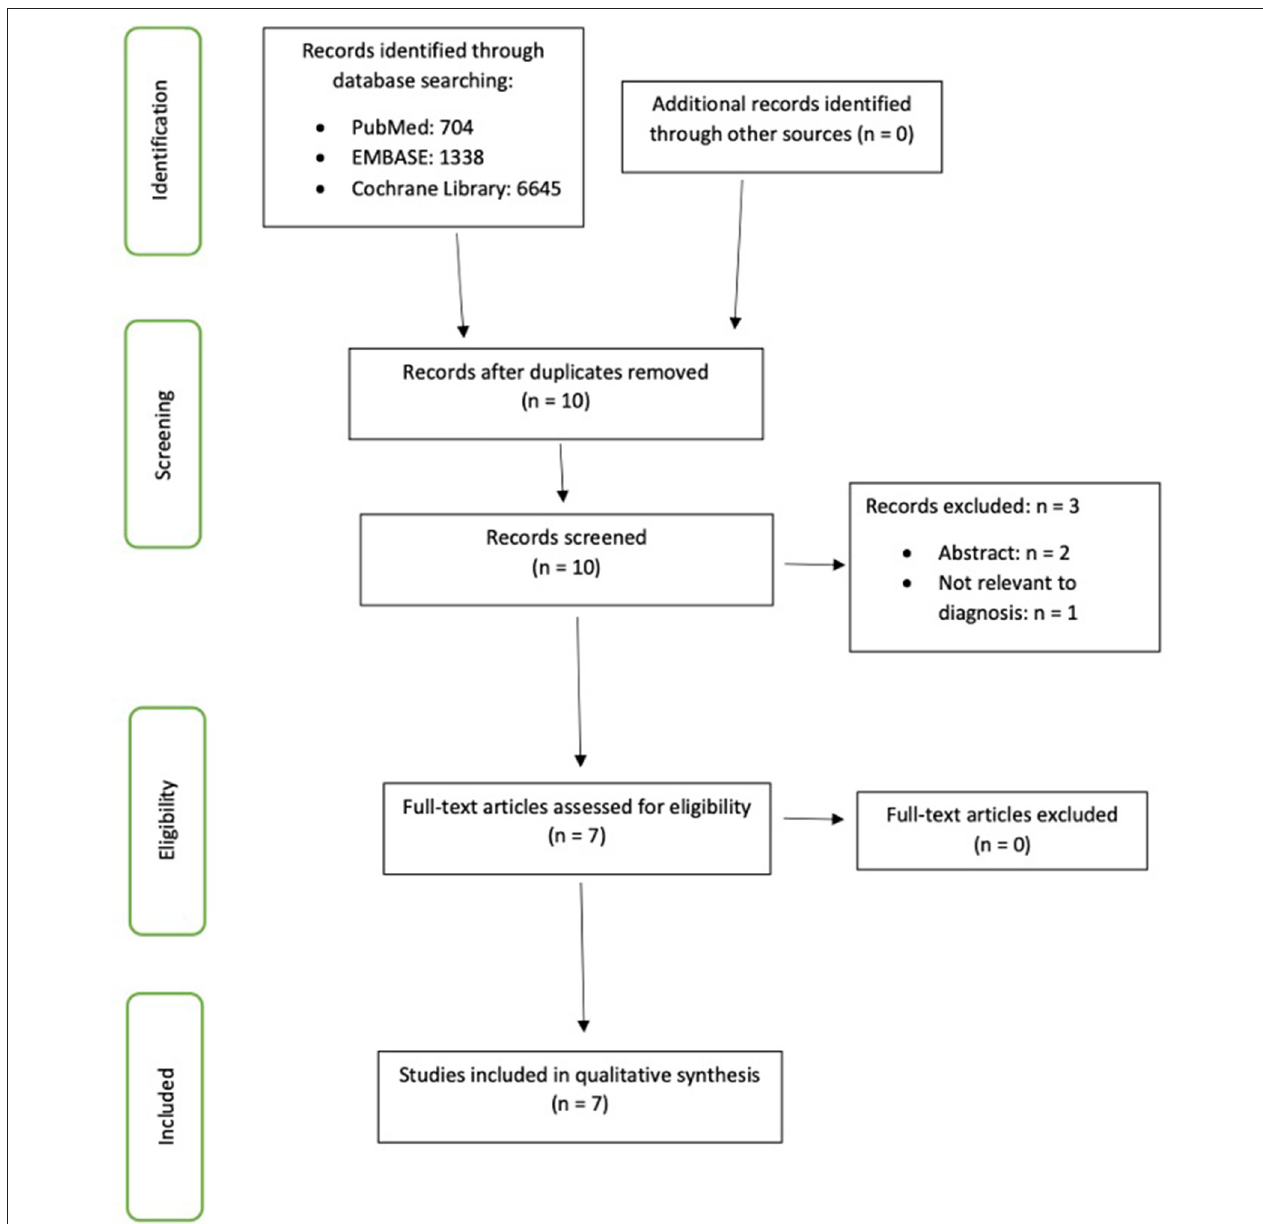
FIGURE 1 | Preferred Reporting Items for Systematic Reviews and Meta-Analysis (PRISMA)-guided flow chart illustrating the screening and selection processes performed to identify the articles included in this review.